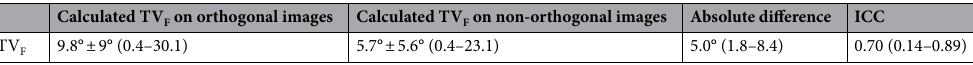
Table 3. To test the validity of using the algorithm on non-orthogonal images, calculated TV F was compared to calculated TV F performed with non-orthogonal images using the ICC. Measurements are demonstrated as mean ± SD (range). Difference is demonstrated as absolute difference as median {interquartile range} due to a non-normal distribution. The ICC is shown with the 95% confidence interval (CI).